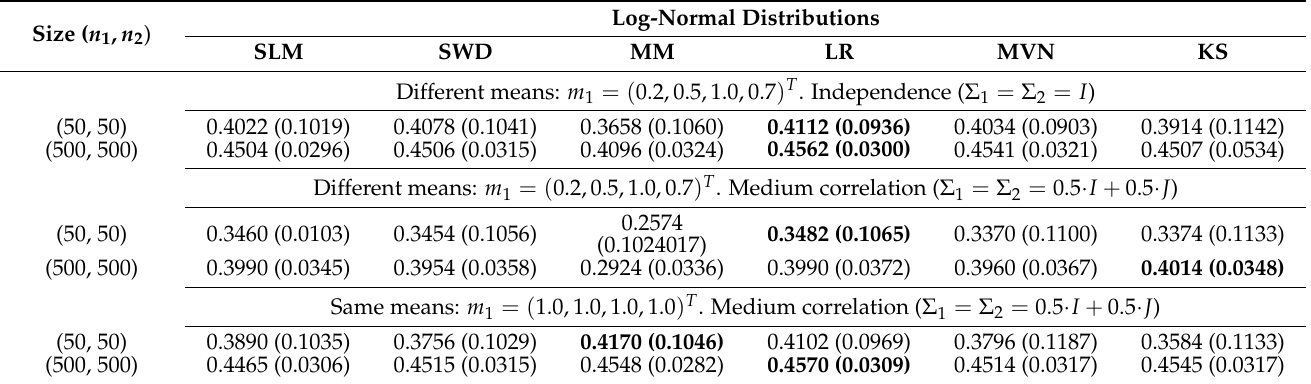
Table 16. Non-normal distributions: Log-normal distributions.